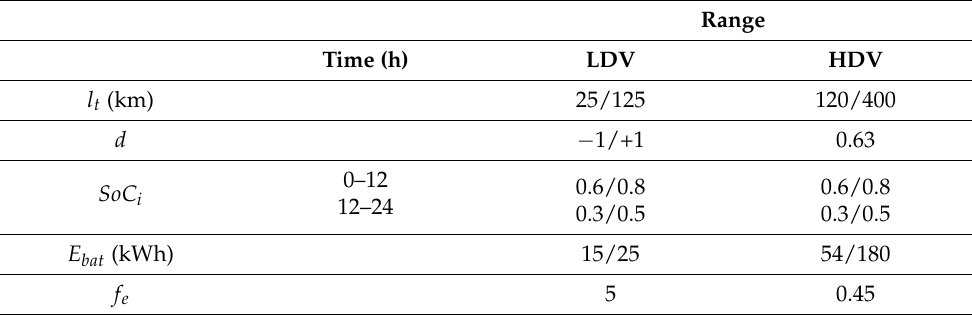
Table 1. Characterization of mobility